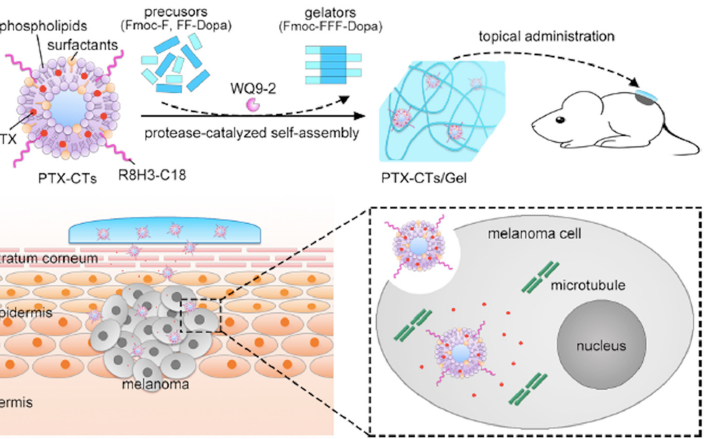
Figure 4. ( a ) Schematic illustration of the preparation and the application of a liposome embed- ding hydrogel as a paintable patch for TDDS. ( b ) Schematic illustration of the enhancement on the efficiency of TDDS for noninvasive chemotherapy of melanoma. Reprinted with permission from ref 63. Copyright 2018 American Chemical Society.